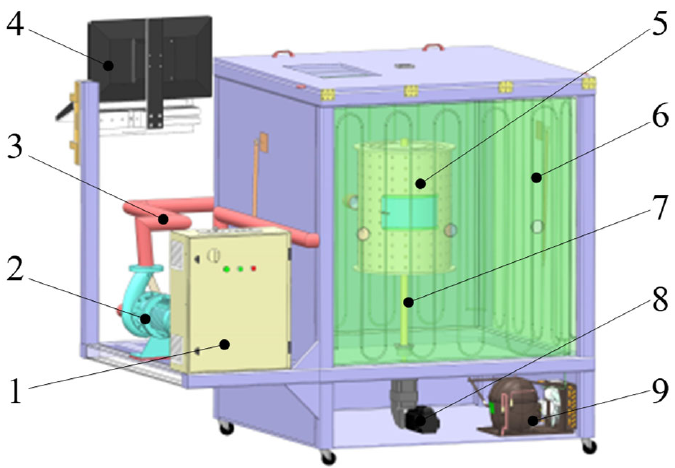
Figure 1. New impregnation and freezing equipment. 1—electric control box; 2—circulating water pump; 3—liquid circulation pipe; 4—display; 5—rotating hopper; 6—condensation tube; 7—rotating shaft; 8—motor; 9—refrigeration equipment.